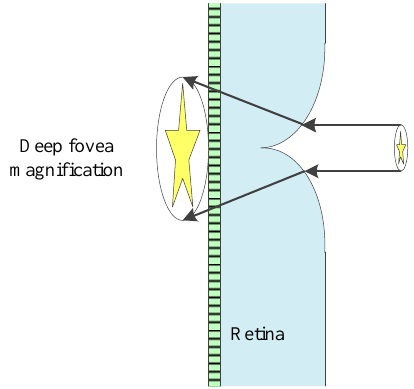
Figure 3. Anatomy of the deep